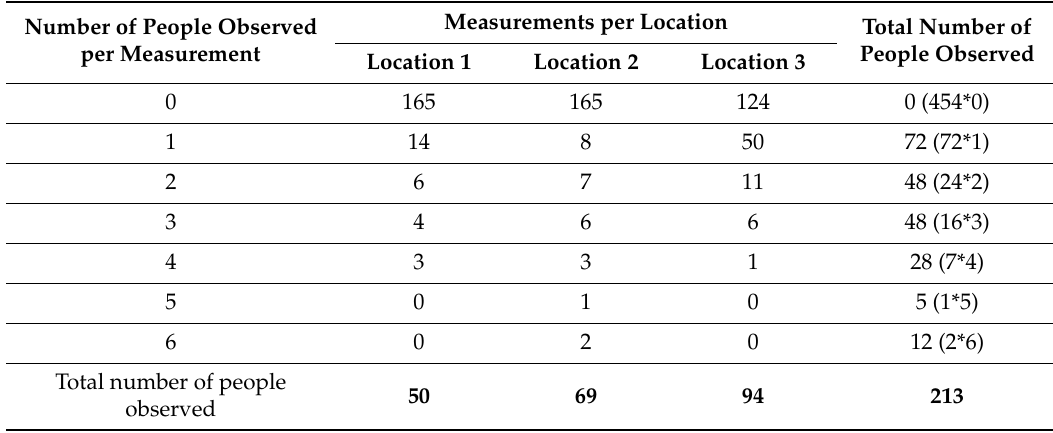
Table A3. Scan sampling: measurements per location, number of people observed during measurement, and total number of people observed in all